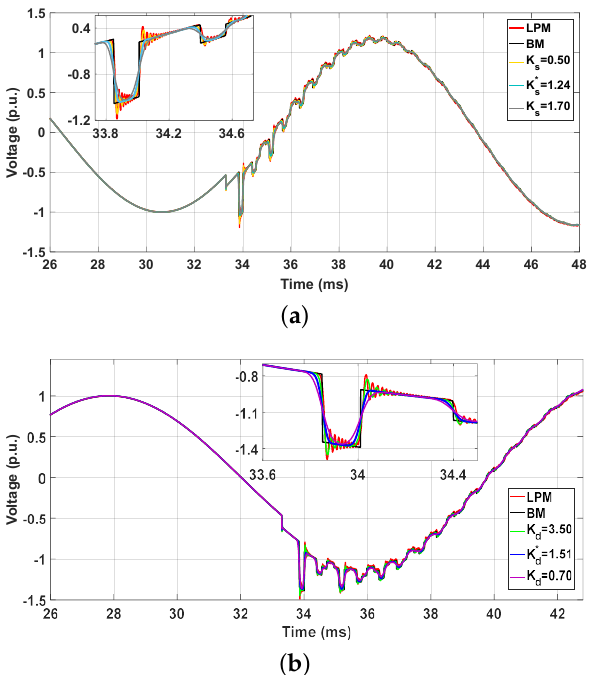
Figure 18. Transient voltages under an earth-fault with LPM, T 2 and BM: ( a ) Phase 2 and ( b ) Phase